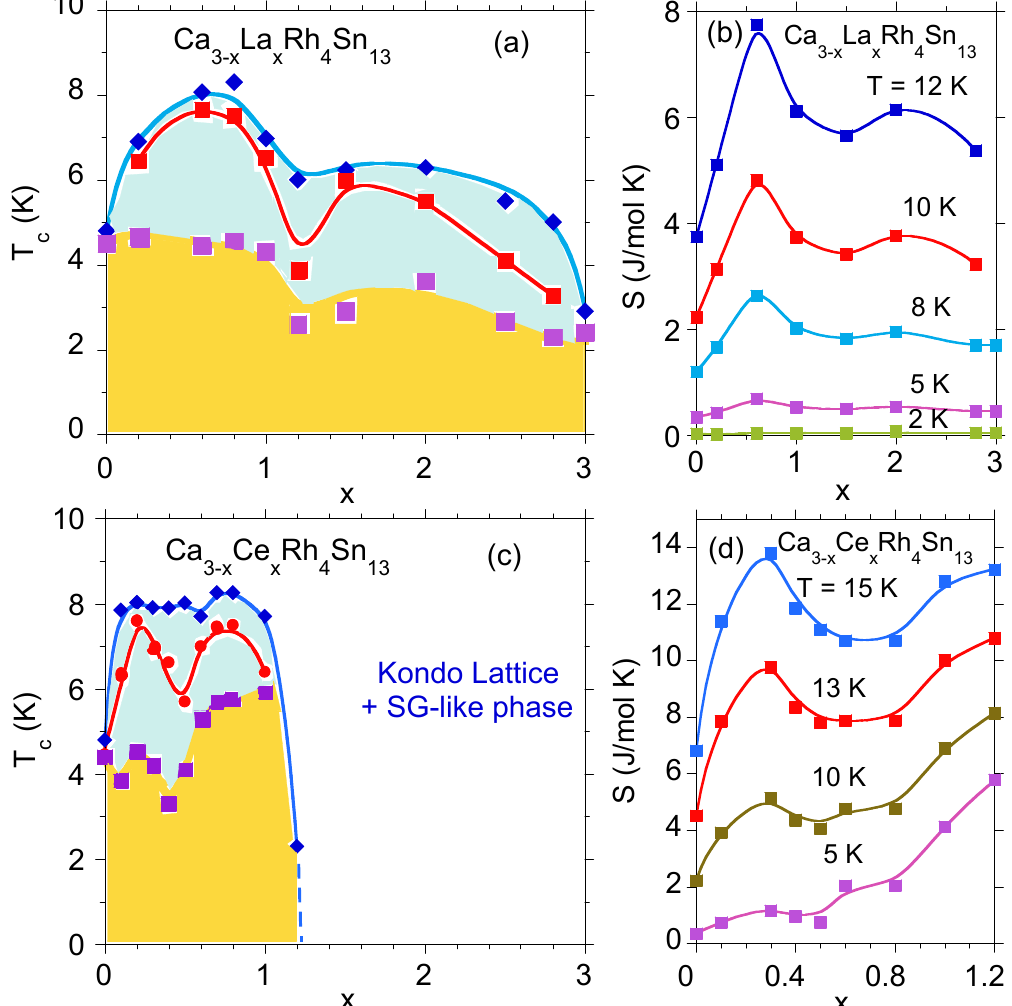
Figure 4. T − x phase diagram for Ca 3 − x La x Rh 4 Sn 13 (panel a ) and Ca 3 − x Ce x Rh 4 Sn 13 ( c ). The blue color shows the area of the high T (cid:63) c phase, the blue line indicates the beginning of the transition from the normal to SC phase, while the red line shows the temperature of the maximum of the f ( ∆ ) function. The yellow color shows the area of the bulk T c phase. Panels ( b , d ) show the entropy isotherms as a function of x for Ca 3 − x La x Rh 4 Sn 13 and Ca 3 − x Ce x Rh 4 Sn 13 ,